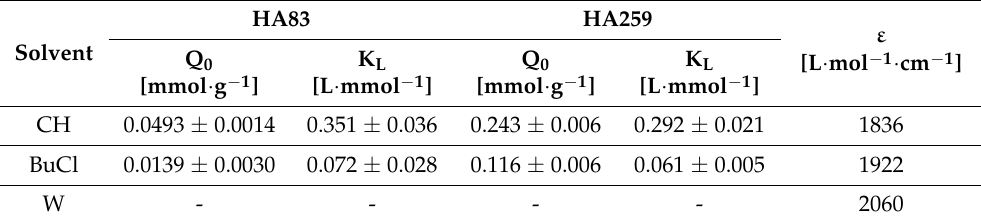
Table 2. Parameters of the fitted Langmuir isotherms and TEMPO molar absorption coefficients for the studied